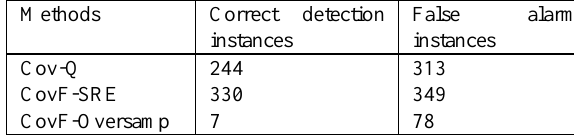
Table 2: Outlier detection results: Chlorine data